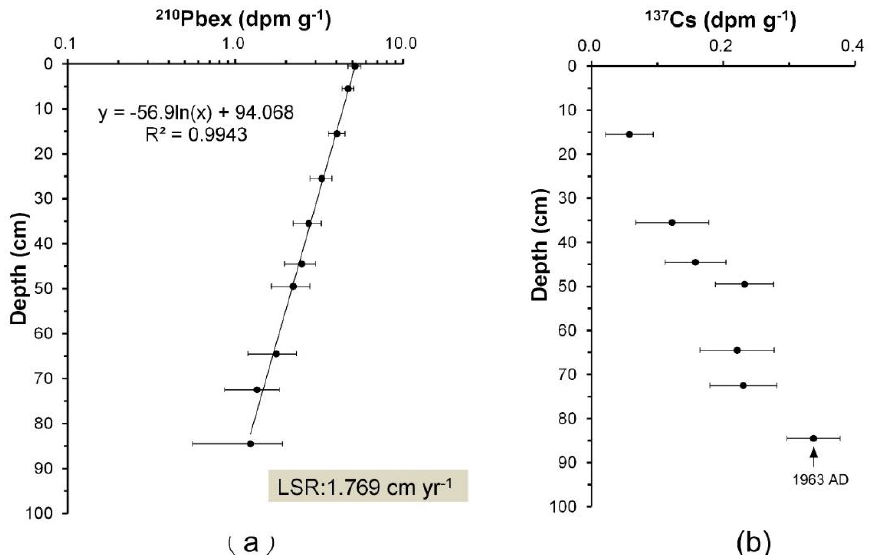
Figure 2. The results of radiometric dating. ( a ) The sediment profile of excess 210 Pb ( 210 Pbex) and an estimation of the linear sedimentation rate (LSR). ( b ) The profile of 137 Cs in the sediment core.